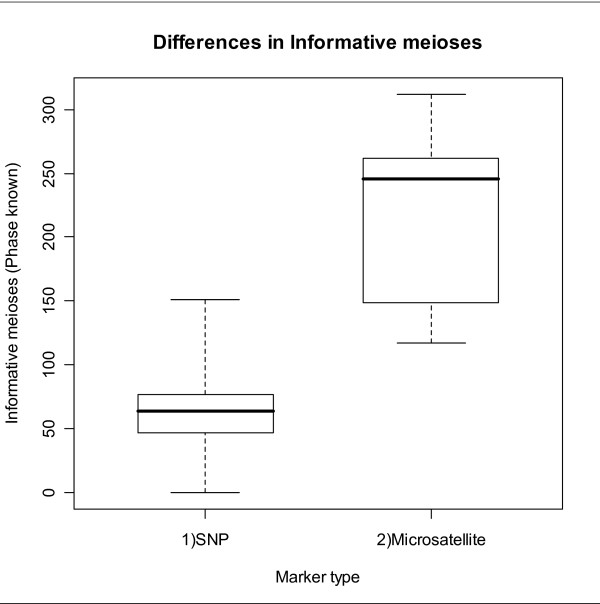
Number of informative meioses. Comparison of the number of informative meioses of microsatellites and SNPs. Informative meioses are highly dependent on the variability of the marker. The microsatellite markers exhibit significantly more informative meioses than the SNPs (t-test, t = 10.71, p < 0.0001(two-tailed), d.f. = 19.44).